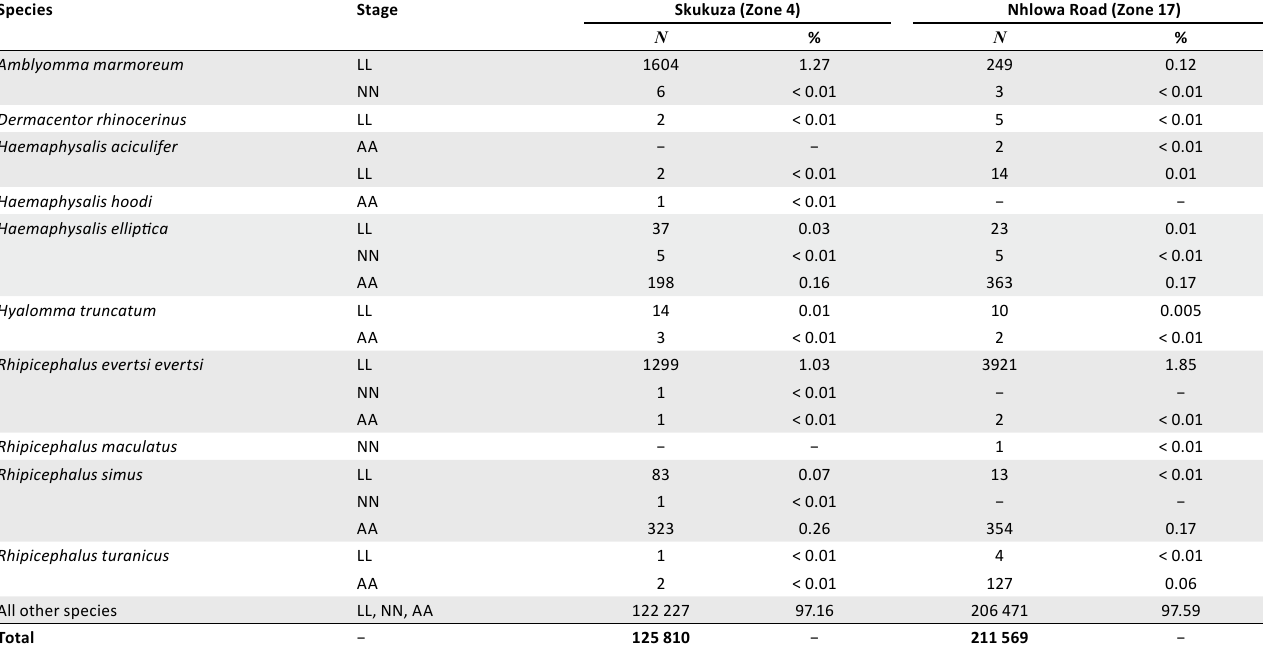
TABLE 1: Numbers of the less common tick species collected by dragging at the Skukuza and Nhlowa Road sites in the Kruger National Park (August 1988–March 2002).